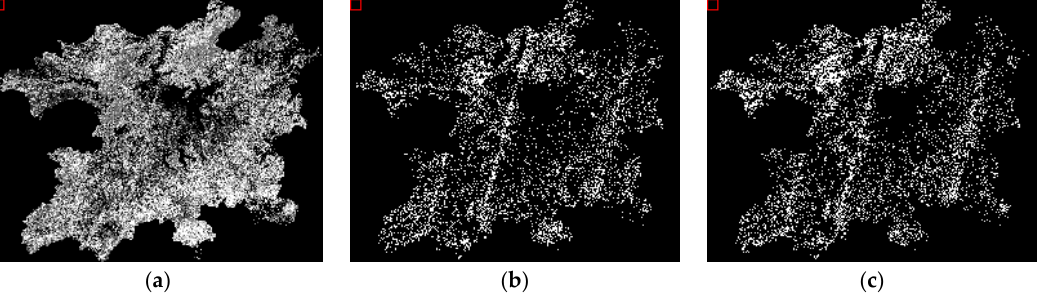
Figure 7. Frequency of illogical transition. ( a ) Plan 1: NPP; ( b ) Plan 2: HMM1-1; ( c ) Plan 8: HMM1-1_spat.